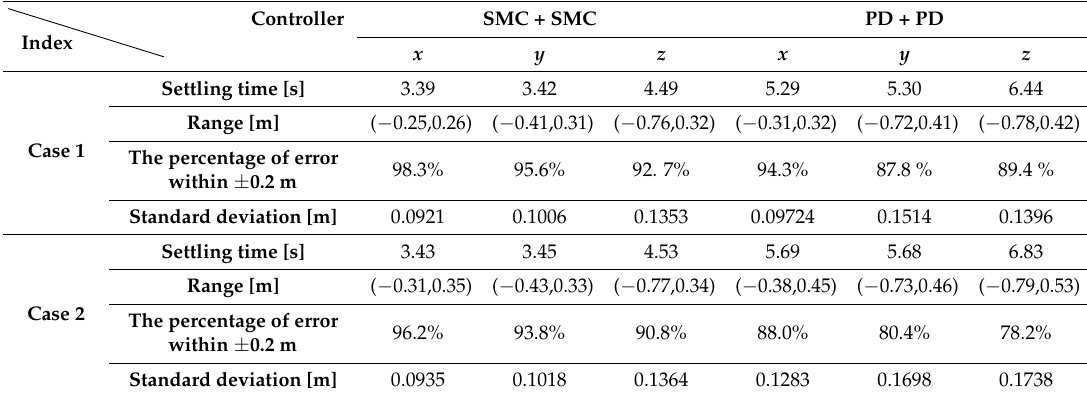
Table 7. Comparison of experimental results under two